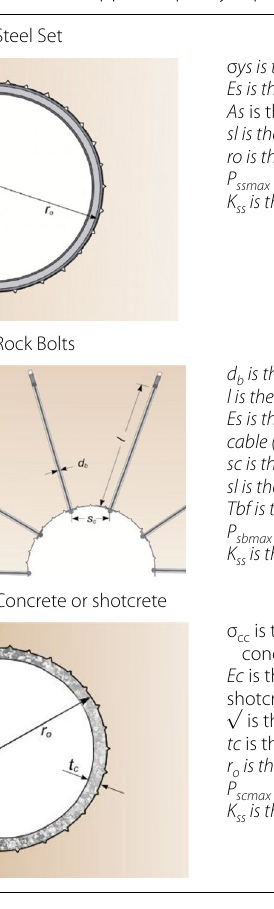
Table 4 Support properties between the portal and km: 210 Shotcrete, C20/25 40 cm Steel rib I200 Rock bolts 6–8 m, self-drilling bolt, Forepoling 12 m, 3.5 or 4 ″ with 6 m overlap Excavation step (m) Top